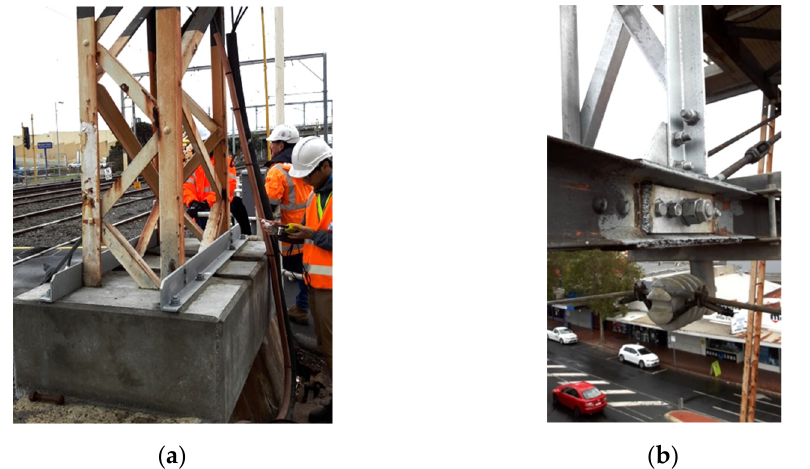
Figure 8. Retrofits of an existing OWS. ( a ) New concrete foundation, ( b ) Partial replacement of steel truss members.